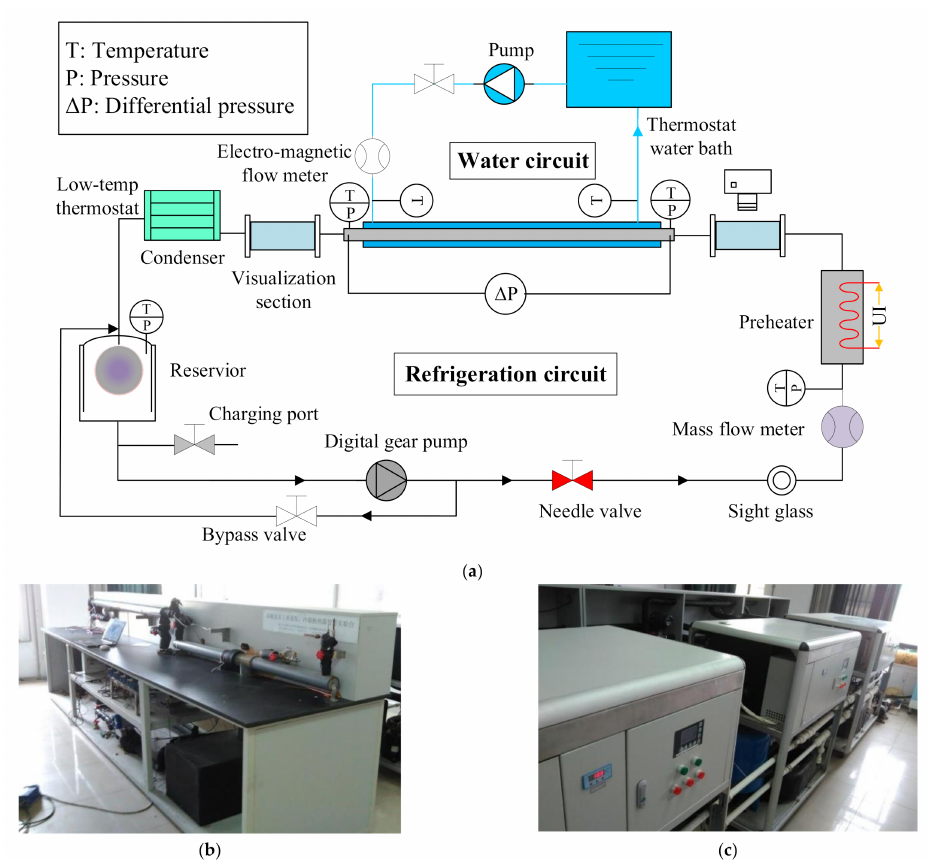
Figure 1. ( a ) Schematic of the experimental setup. ( b ) Front view of the experimental setup. ( c ) Rear view of the experimental